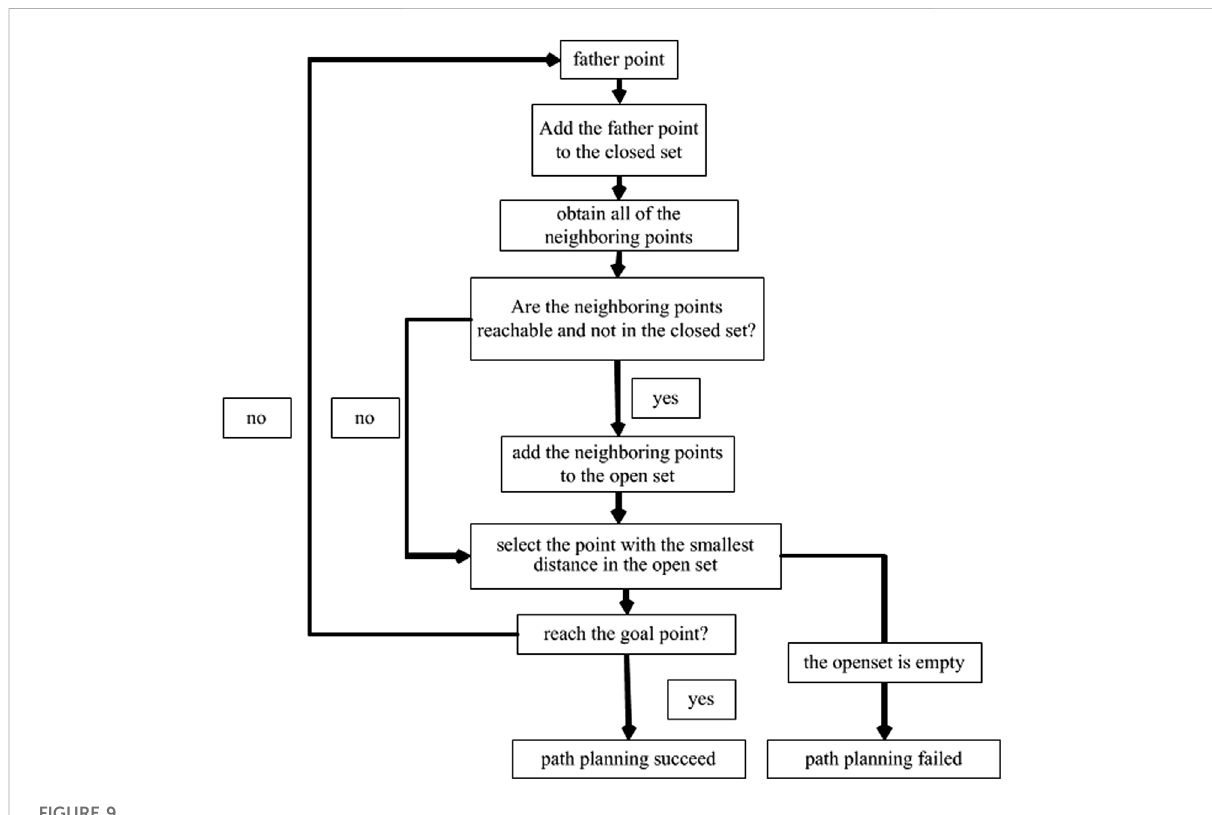
FIGURE 9 A* algorithm.